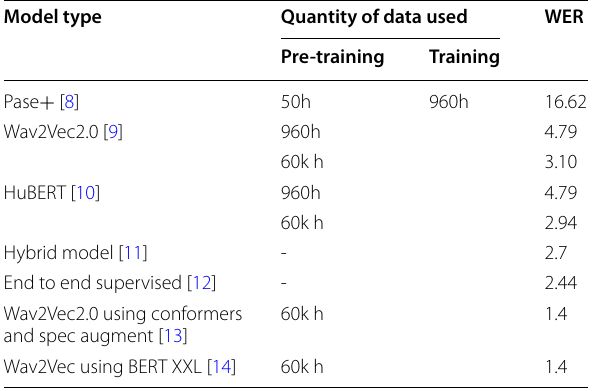
Table 3 SOTA results over IEMOCAP using 4 emotions (happiness, neutral, anger, and sadness) and quantity of data used. Self-supervised results come from [7] experiments